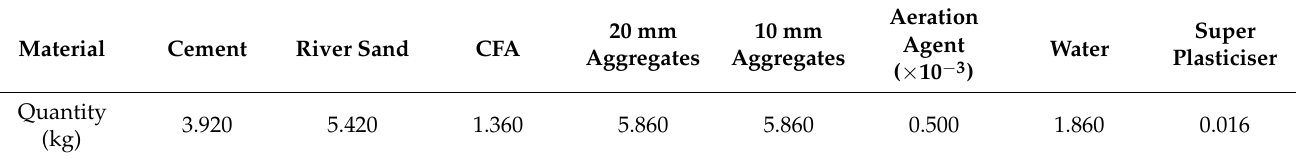
Table 1. Mix design of the CFA-based concrete.